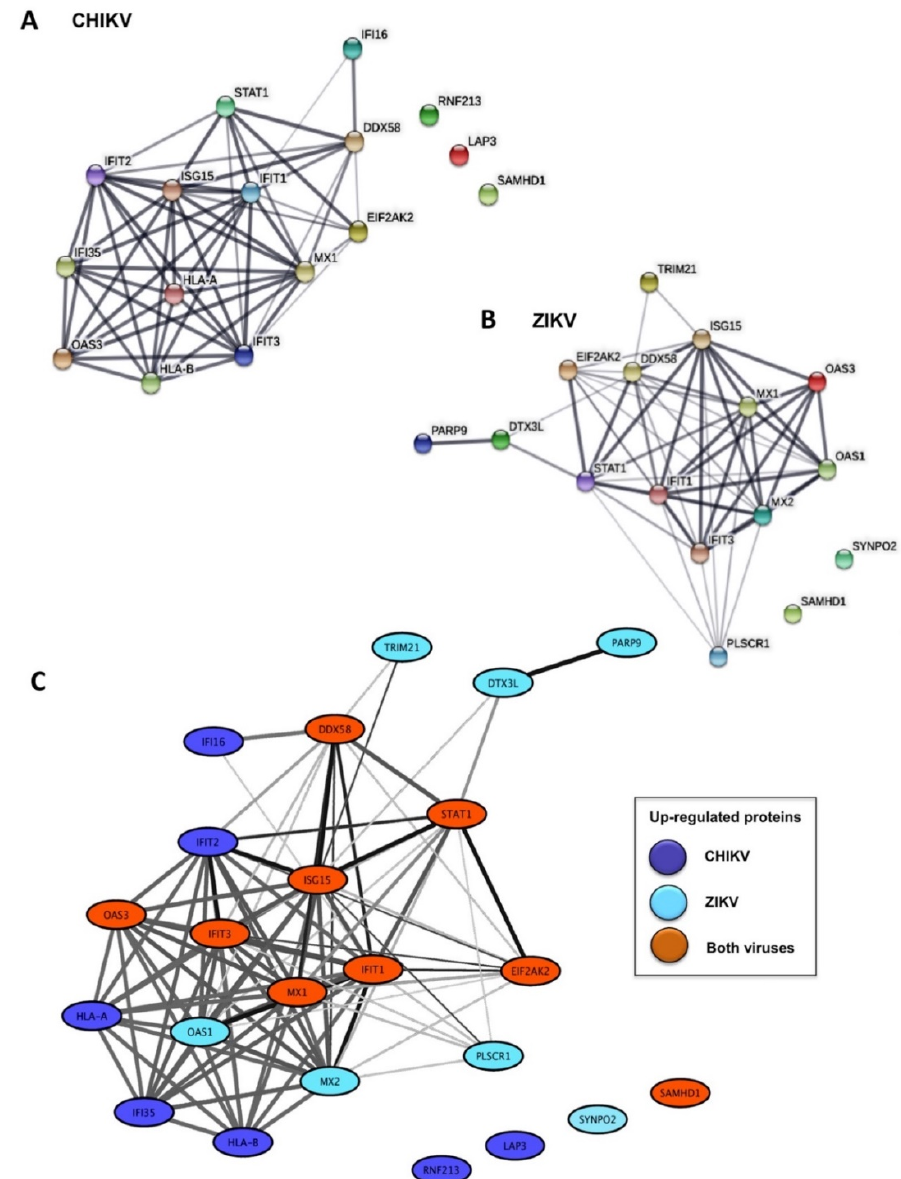
Figure 1. Network representation of proteins significantly up-regulated in CHIKV and ZIKV-infected HFF1 cells: ( A ) functional interaction network among significantly up-regulated proteins in CHIKV-infected cells; ( B ) functional interaction network among significantly up-regulated proteins in ZIKV-infected cells; and ( C ) merged functional interaction network among all significantly up-regulated proteins in both CHIKV- and ZIKV-infected cells. Proteins are represented as nodes and functional relationships by edges. The thickness of edges is proportional to the confidence level of the functional relationship.